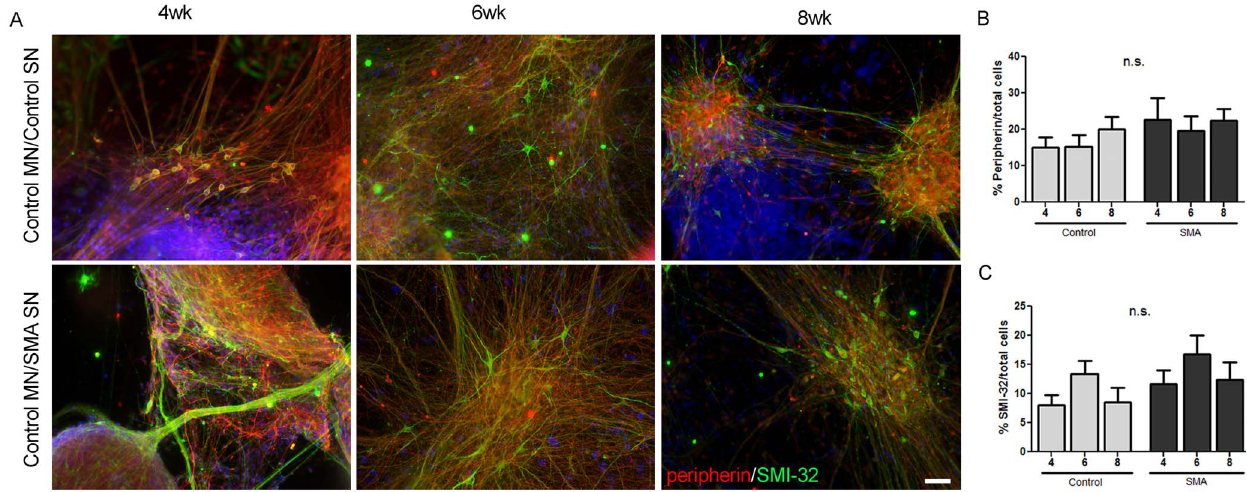
Figure 5. The presence of SMA iPSC-derived sensory neurons does not induce motor neuron loss at 4, 6, and 8 weeks of differentiation. (A) Co-culture of control iPSC-derived SMI-32 + (green) motor neurons (MN) with either SMA iPSC-derived peripherin + (red) sensory neurons (SN) or control iPSC-derived peripherin + (red) SNs does not induce motor neuron loss. Nuclei are labeled with Hoechst nuclear dye (blue). Quantification is shown in B and C. n.s.=not significant by ANOVA. Scale bar=50 m